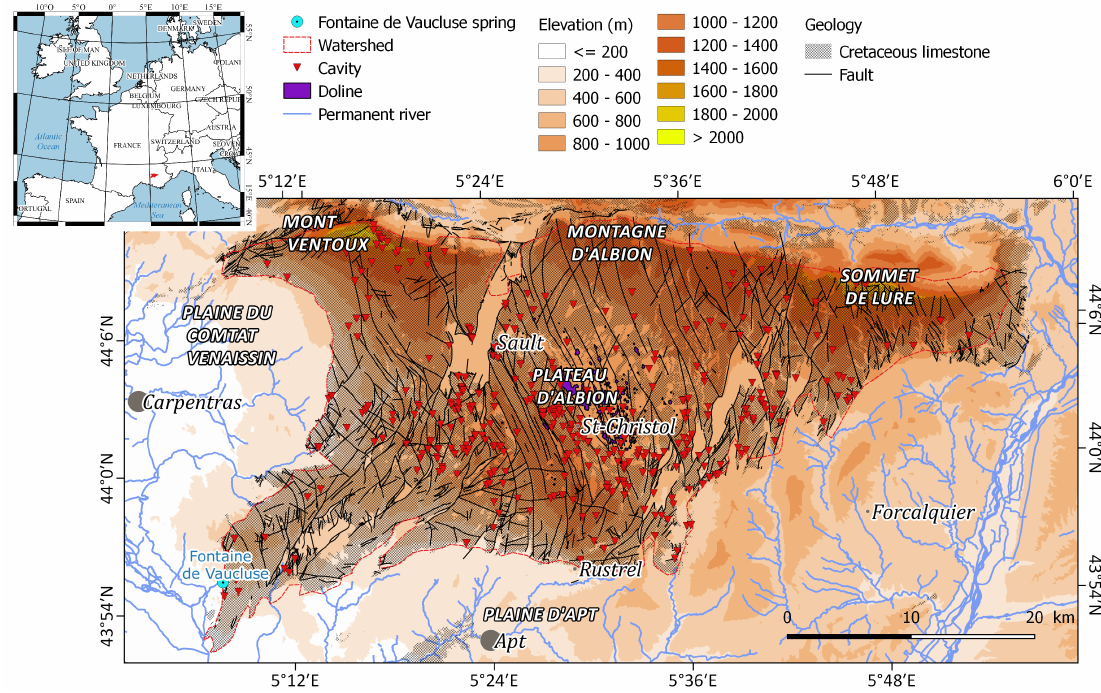
Figure 1. Fontaine de Vaucluse karst aquifer location in South of France. The aquifer is composed of early Cretaceous limestone that is highly fractured (black lines). Numerous karst features are present on the landscape: Caves (red triangles), dolines (violet polygons) and dry valleys (dark grey